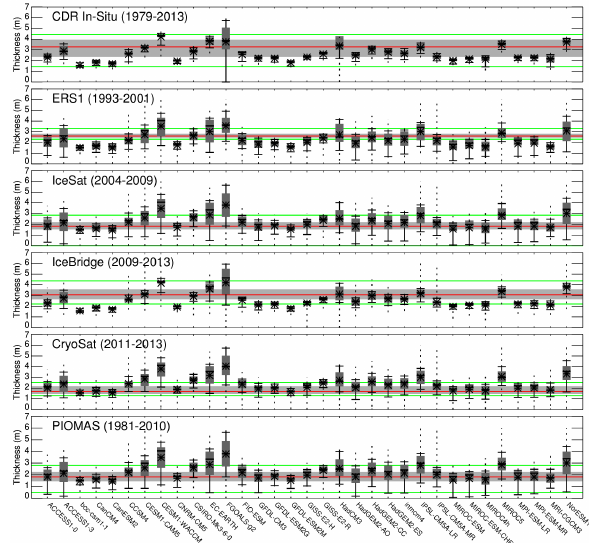
Figure 3. Comparison of thickness distributions between five ob- servational data sets, PIOMAS and 33 individual CMIP5 models. Model results are presented as box and whisker plots from 1981 to 2010, where the boxes represent the interquartile range (25th to 75th percentiles) and the horizontal bars and asterisks within each box define the median and mean, respectively. The median spring thick- nesses from each observational data set and PIOMAS are shown as a solid red line, together with the 10th and 90th percentiles (green lines) and the interquartile range (gray